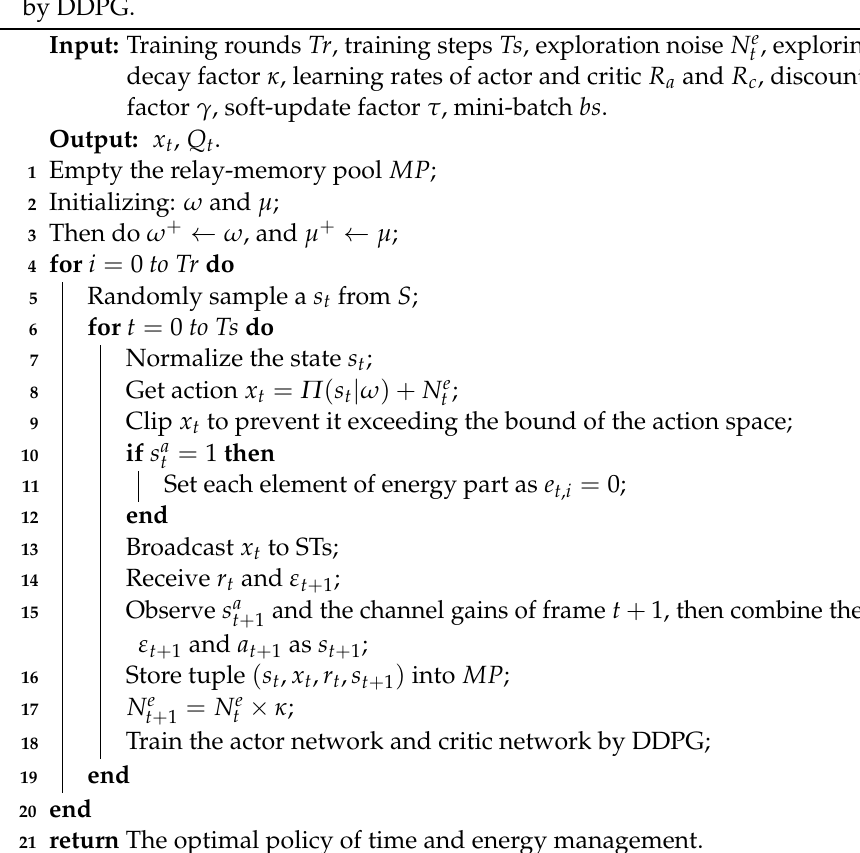
Algorithm 1: Finding the optimal policy for the time and energy management by